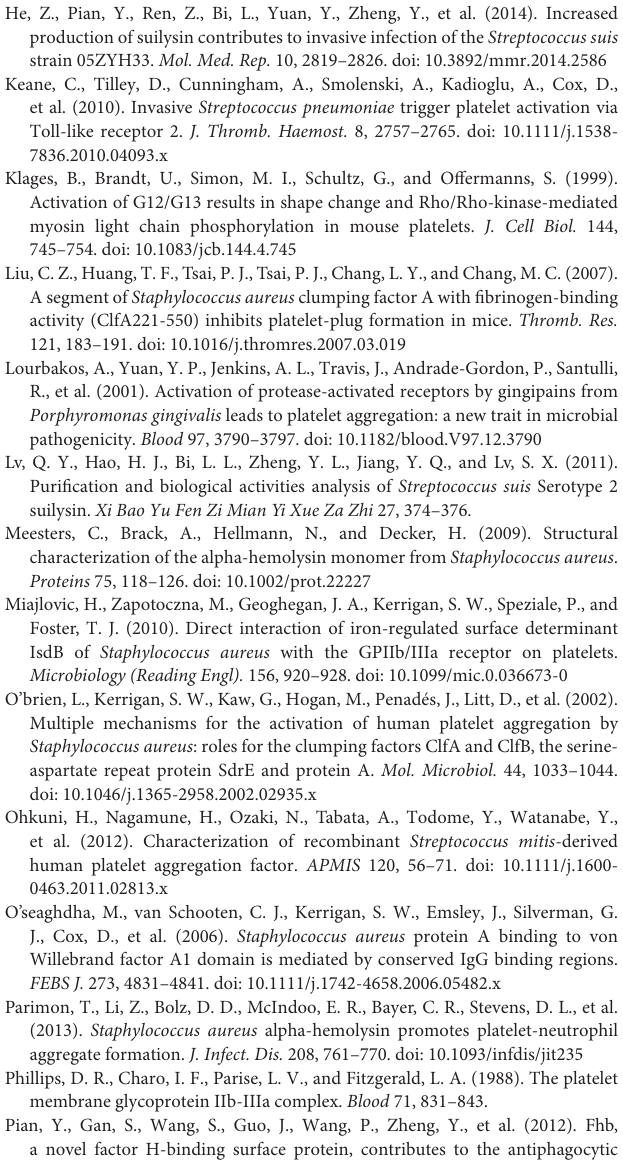
Figure S3 | S. s uis supernatant and rSLY-induced platelet aggregation in PRP was assessed in the presence of 15 µ L anti-CD62P blocking antibody or an isotype-matched control antibody (BD Bioscience). Unpaired two-tailed Student’s t -test was used for statistical analysis. Data in are expressed as the mean ± SD for three independent experiments, with each experiment using blood from a different donor. P < 0.05 is considered as the threshold for significance; ns, no significance; 05ZYH33, wild type strain; 1 sly, The isogenic mutants of sly; Sup, supernatant. Figure S4 | Dose response of rSLY-induced platelet aggregation. Serial concentrations of SLY were added to platelet-rich plasma (PRP) in a stirred cuvette. Platelet aggregation was expressed as a final percentage of light transmission. Table S1 | Bacterial strains and plasmids used in this